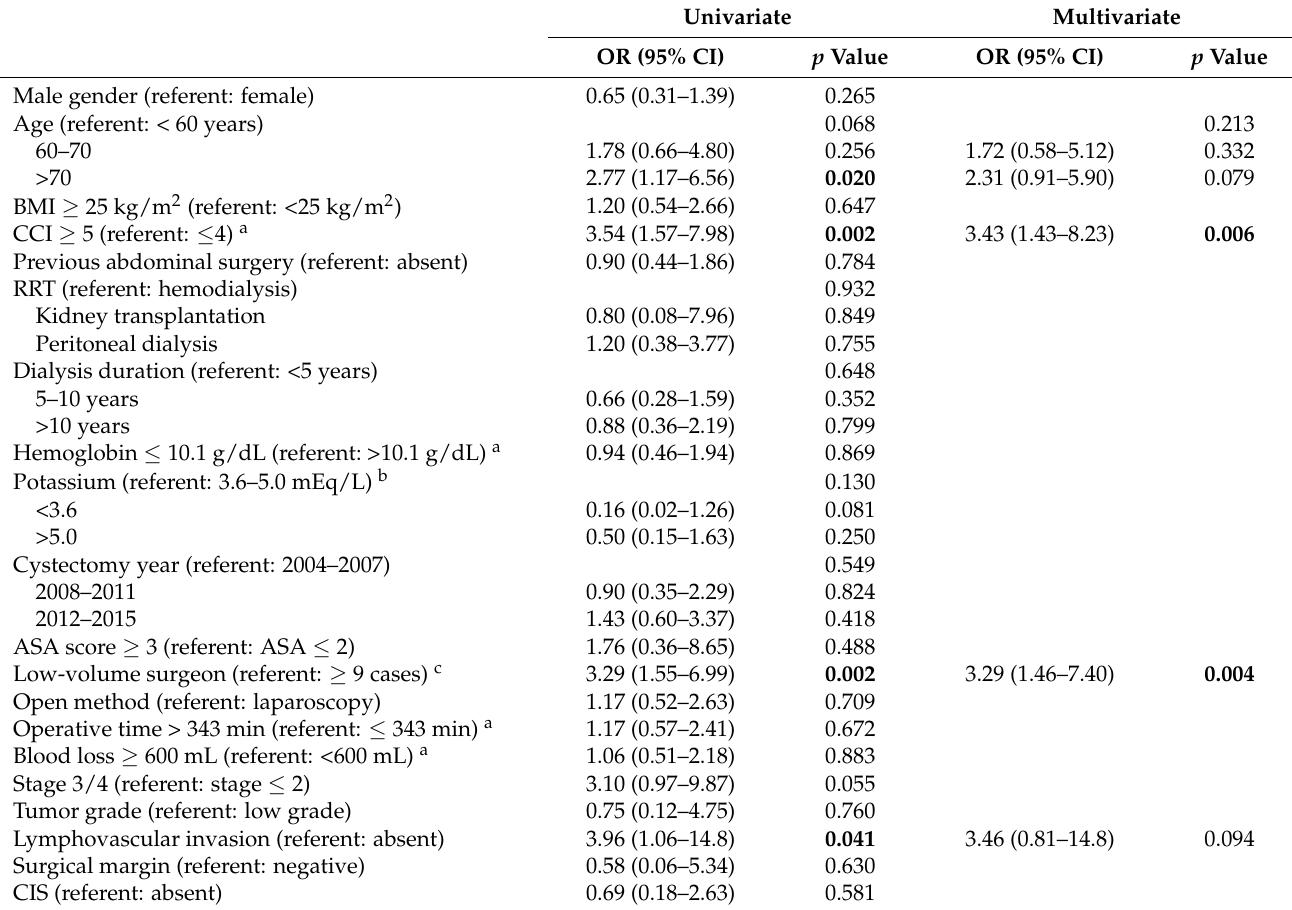
Table 4. Univariate and multivariate analysis for predictive factors of postoperative major complications. Univariate